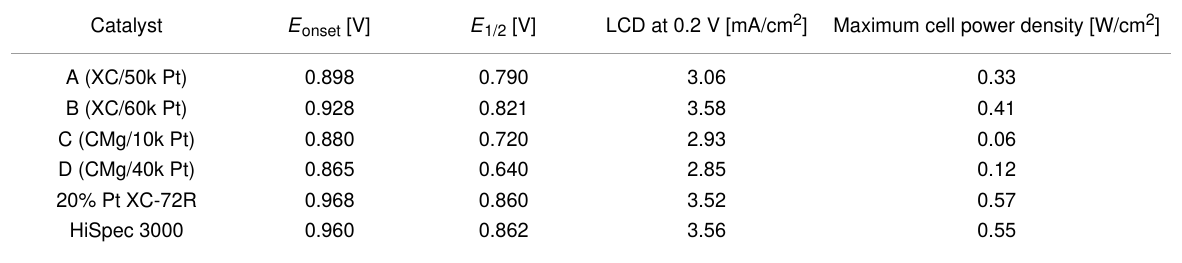
Table 2: Onset potentials ( E onset ), half-wave potentials ( E 1/2 ), and limiting current densities (LCD) at 0.2 V determined on the basis of RRDE electro- chemical experiments performed for all Pt-based catalysts at 900 rpm, and maximum cell power density determined on the basis of Figure 7b